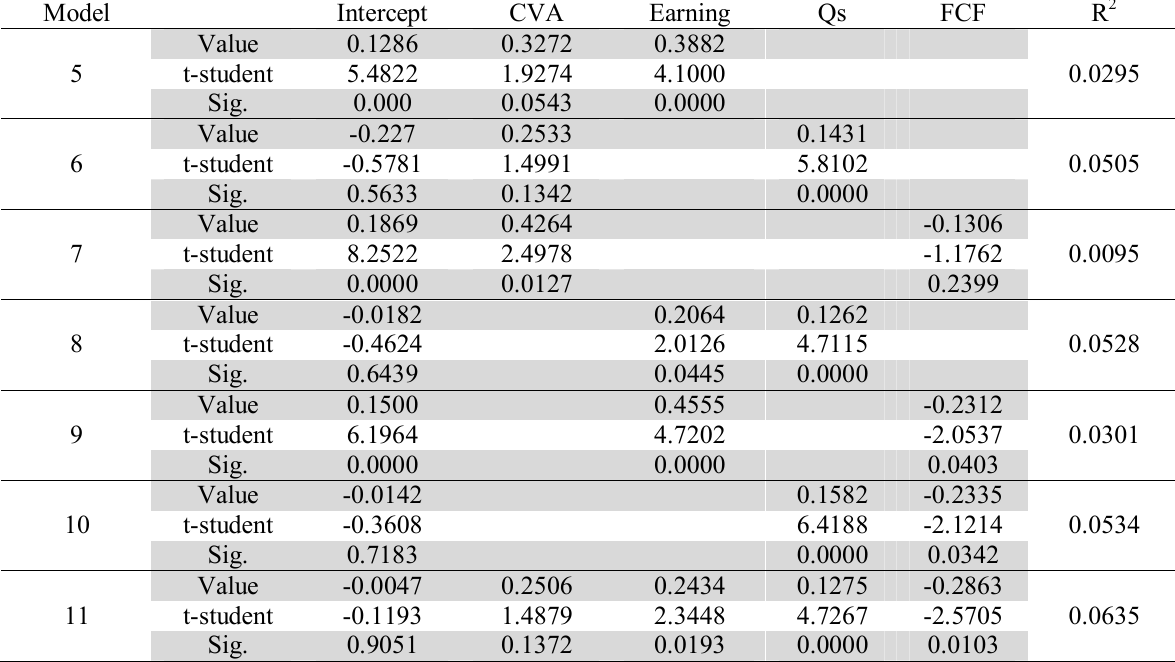
The summary of regression results for the third hypothesis Model